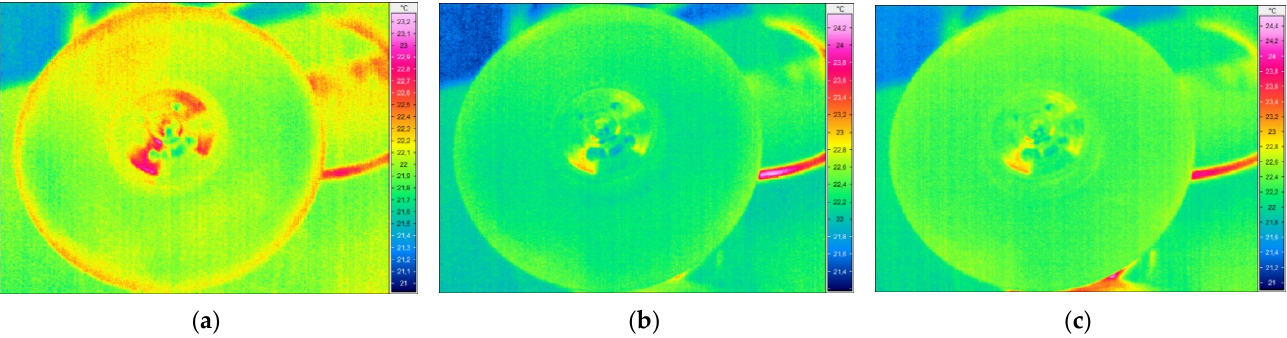
Figure 13. The selected thermograms obtained during the SHVT testing of the larger disk with excitation frequencies of ( a ) 33.75 Hz; ( b ) 178.75 Hz; ( c ) 997.5 Hz.